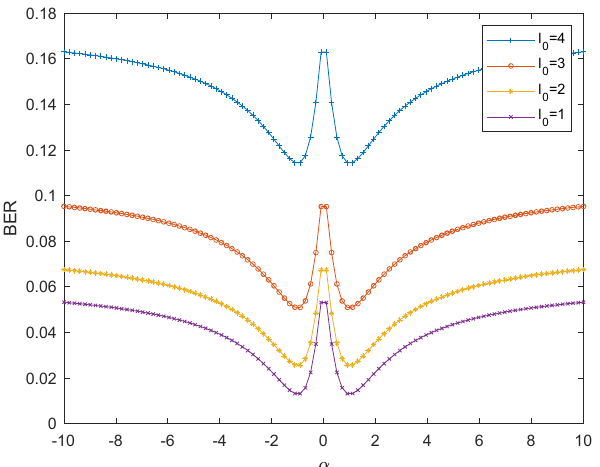
Figure 3. BER of the coaxial double-position power Gaussian vortex carrier communication link versus dimensionless parameter | α | for different topological charge of vortex.